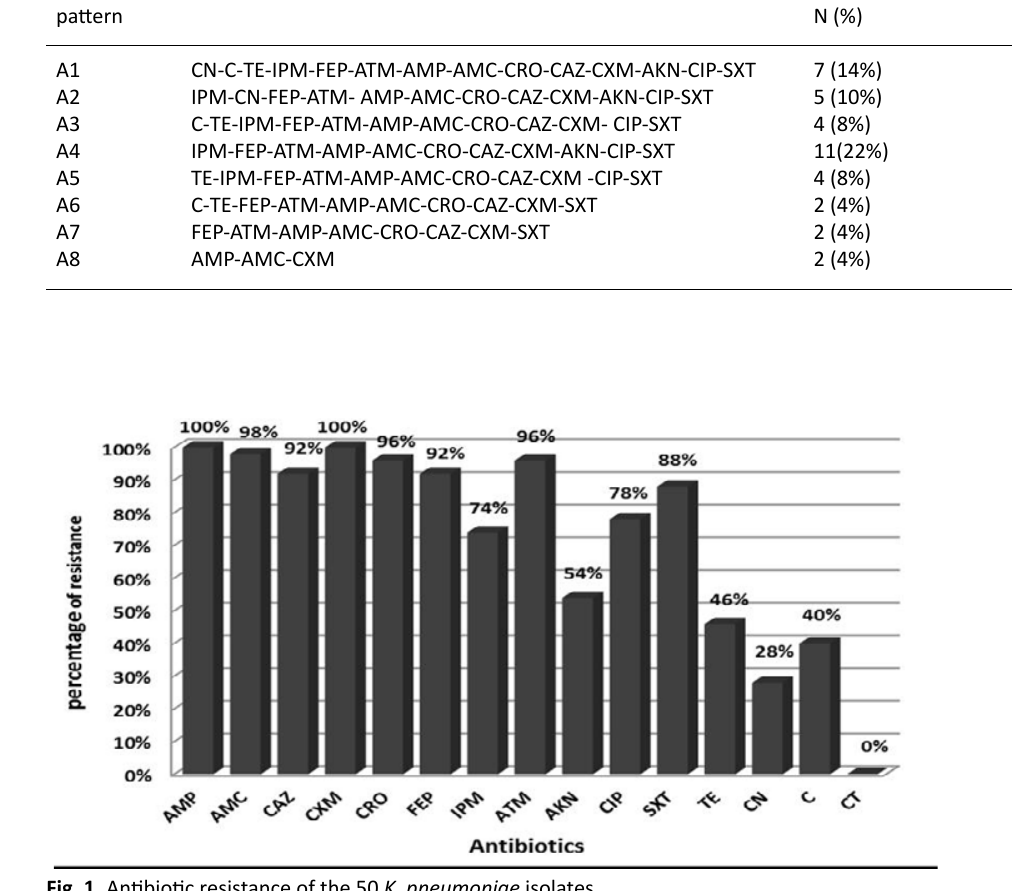
Fig. 1. Antibiotic resistance of the 50 K. pneumoniae